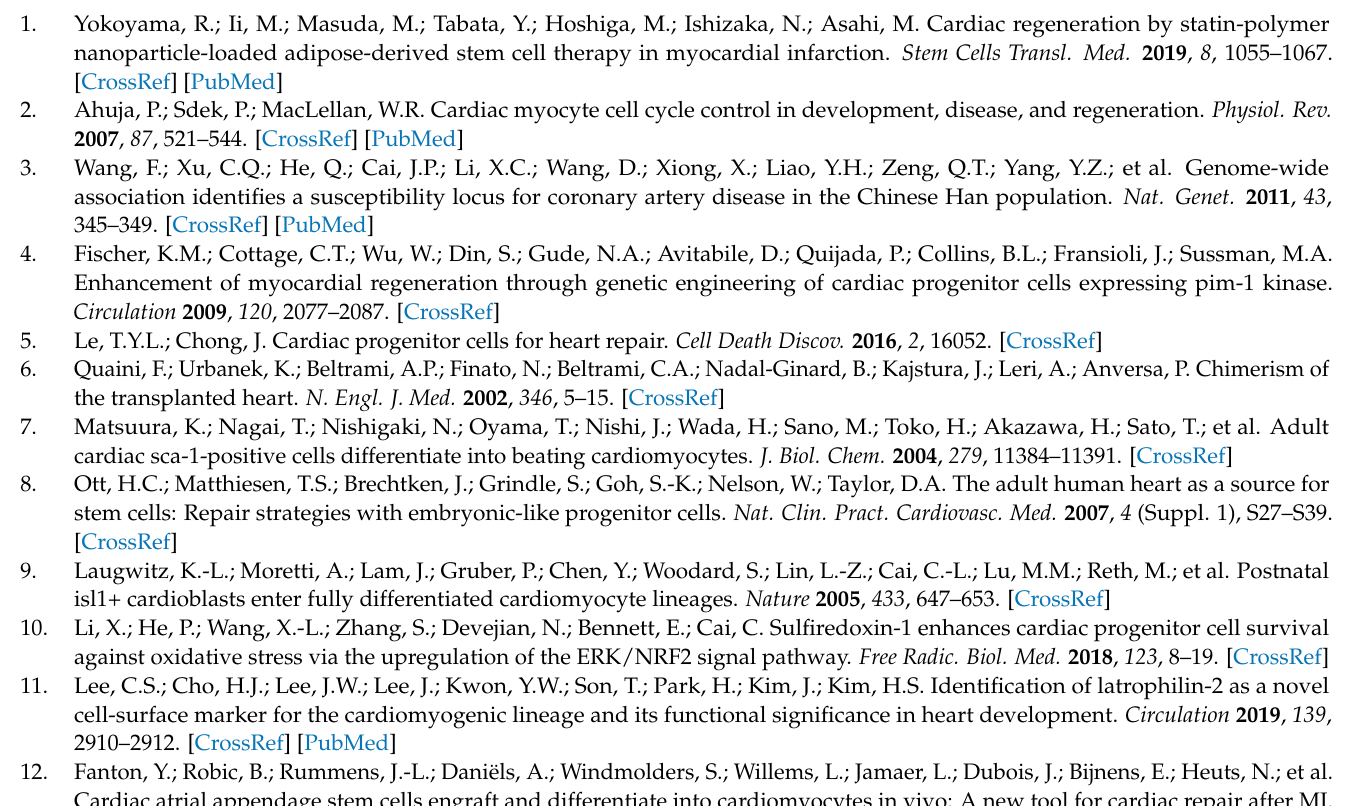
I. Table S3: List of genes in the human cytokine primer library II. Table S4: Human cytokine antibody table. Detailed Supplementary Methods. References [10,41–43] are cited in Supplementary